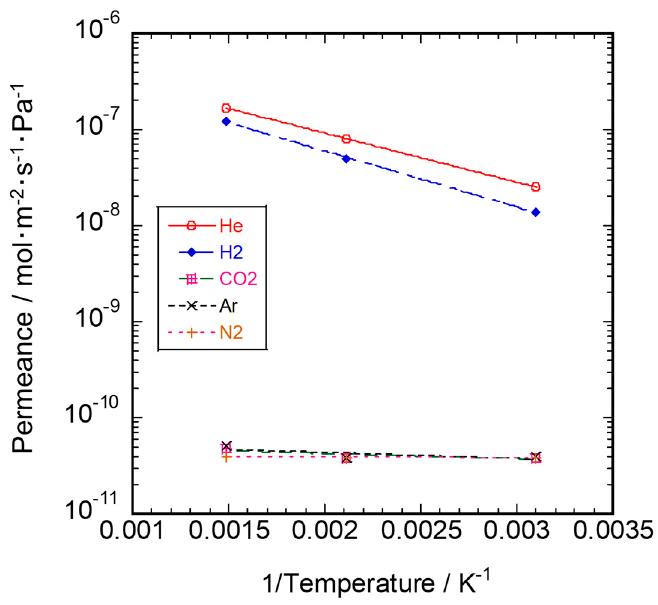
Figure 11. Single gas permeance of SiC membrane in the temperature range 323–673 K.